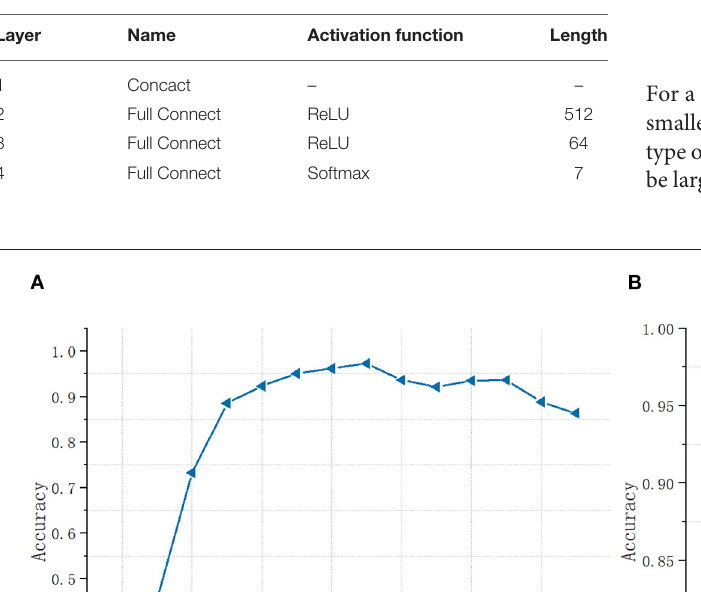
TABLE 4 | Classification layer network structure.